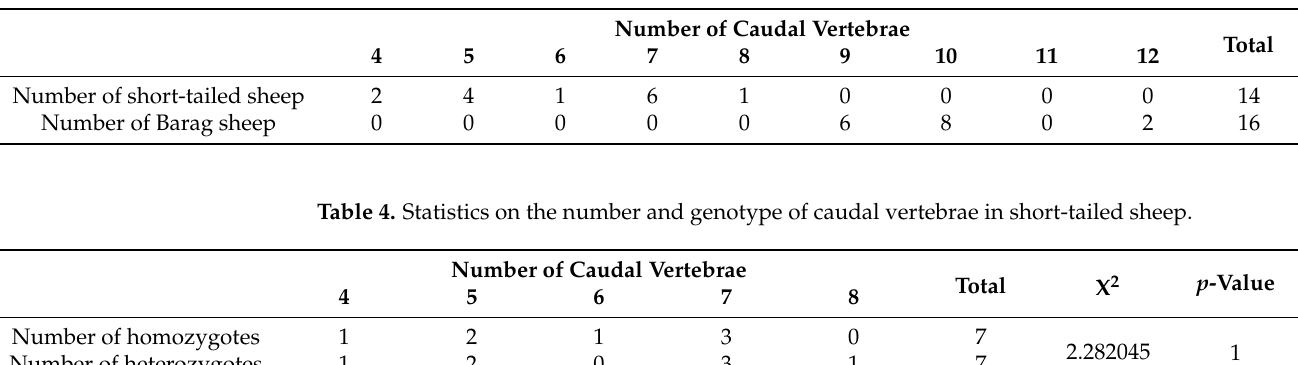
Figure 3. HRM genotyping results. ( a ) Typical shapes of the melting curves corresponding with the three genotypes (C-T/C-T, C-T/G-G, and G-G/G-G). The color of the curve is automatically assigned by PikoReal TM software. The vertical axis represents the change in fluorescence intensity and the abscissa represents the Tm value. The value of the abscissa corresponding with the main peak of each curve is the Tm value of the amplified fragment. ( b ) The melting curve image generated during the genotyping of Barag sheep and short-tailed sheep (a total of 32 samples are shown in the image; each sample was run in triplicate). 4. Discussion One of the purposes of the tail of a sheep is to help the sheep retain energy and fat [41]. When food is scarce, fat from the tail can be utilized to keep the body functioning smoothly [14]. Tail docking not only causes a stress reaction in lambs but also increases the risk of wound infection [42–44]. Short-tailed sheep can be actively raised by farmers to avoid the previously mentioned aberrant state and enhance animal welfare [9,45–47].